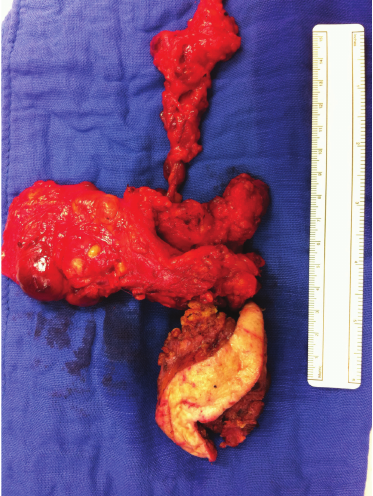
F 5: Parotidectomy and neck dissection specimen measuring cm × 15